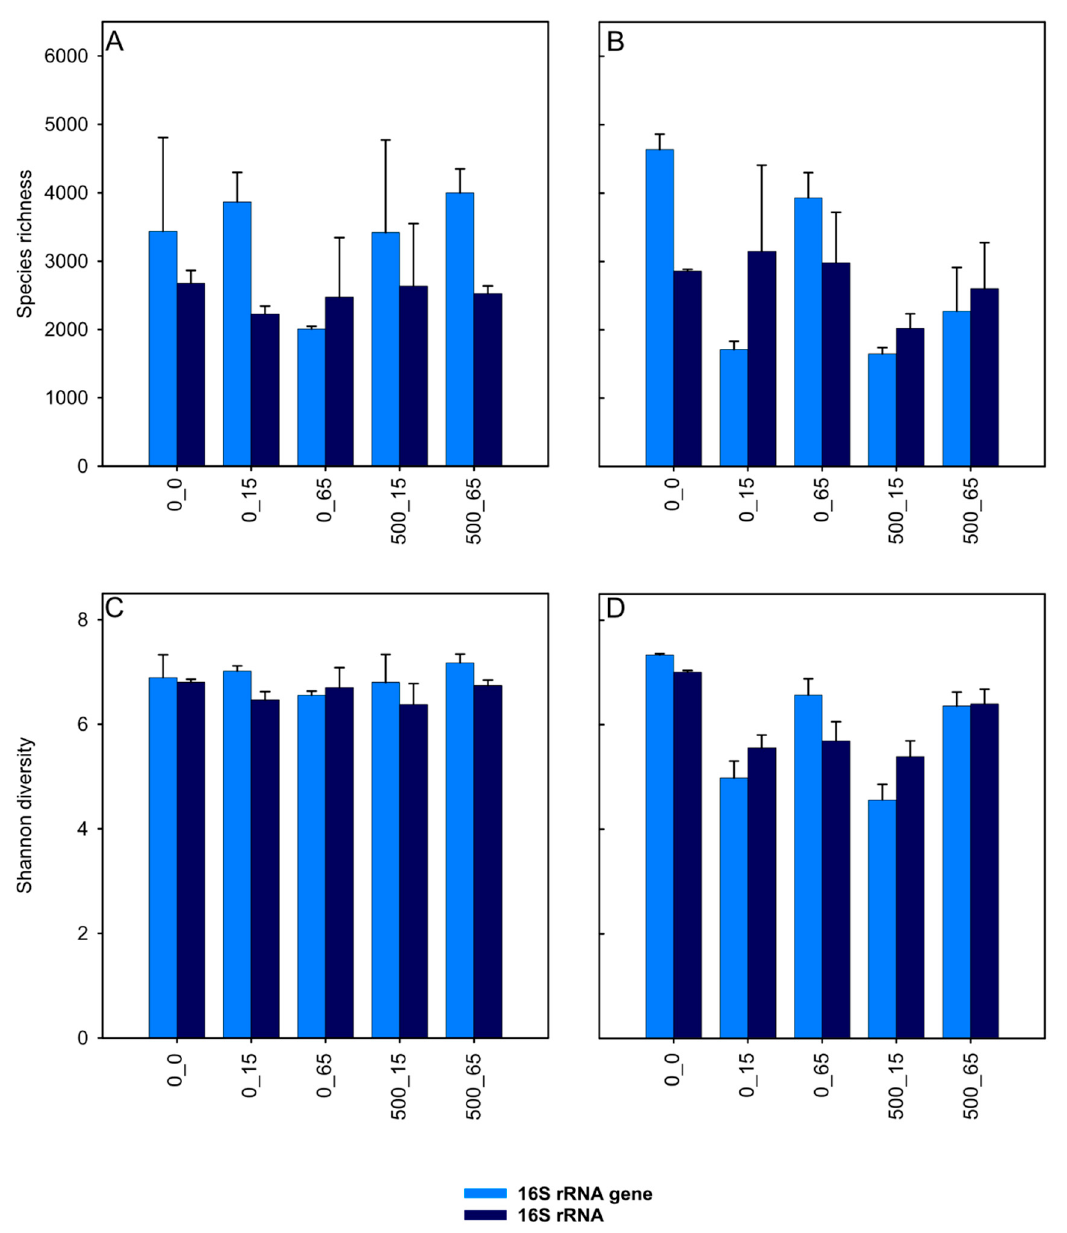
Figure 3. Taxa richness ( A , B ) and Shannon diversity ( C , D ) of the total bacterial community in surface ( A , C ) and subsurface ( B , D ) sediment samples. Sample code: 0, 500 indicate supplemental TrOC concentrations in µg L − 1 . 0, 15, 65 represent sampling days. Values are the arithmetic means of triplicate incubations. Error bars indicate standard deviations.